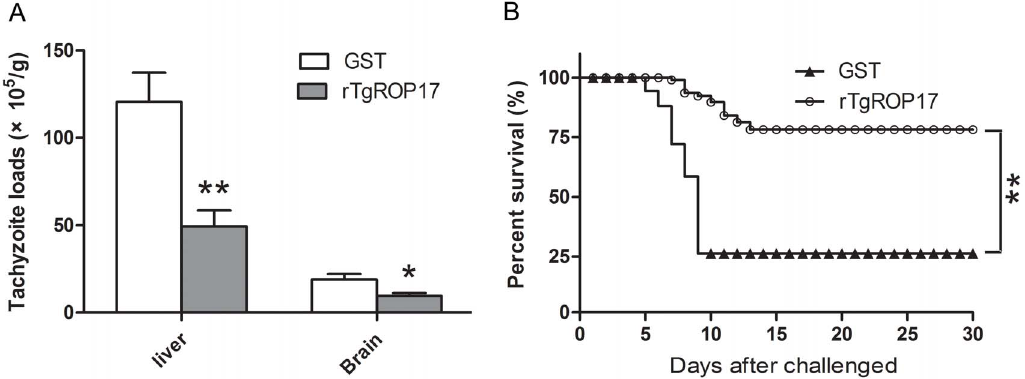
Figure 4. The tachyzoite burdens and survival rates of rTgROP17-immunised mice after oral challenge with T.gondii . The mice were nasally immunized with rTgROP17 or GST control. Two weeks after the final immunization, the mice were orally challenged with 1 6 10 4 tachyzoites (A) or 4 6 10 4 tachyzoites (B) of the T. gondii RH strain. (A) The liver and brain tachyzoite burdens of two groups of mice (n=8 per group) were evaluated one month after the challenge, and (B) the survival rates of other two groups of mice (n=12 per group) were monitored daily for 30 days following the challenge. The values are presented as mean 6 SD from two independent experiments. * P , 0.05, ** P , 0.01 relative to GST control